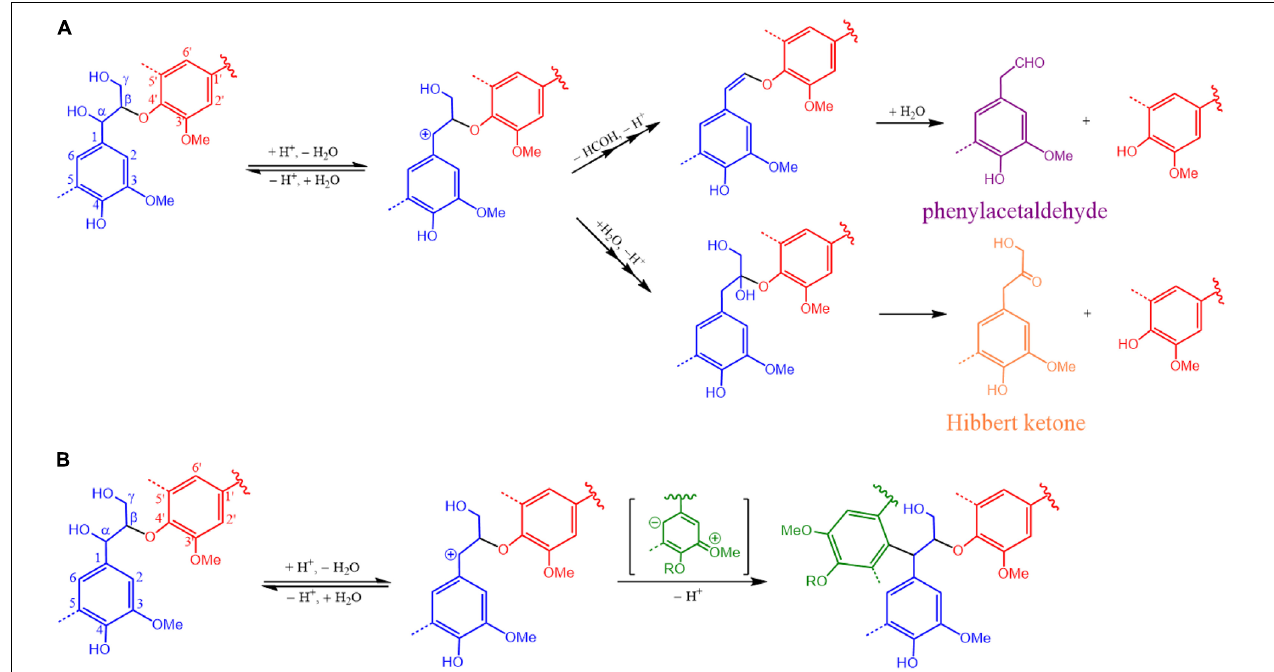
TABLE 2 | CELF lignin hydroxyl contents determined by quantitative 31 P NMR analysis. OH content, mmol/g lignin CELF1 CELF2